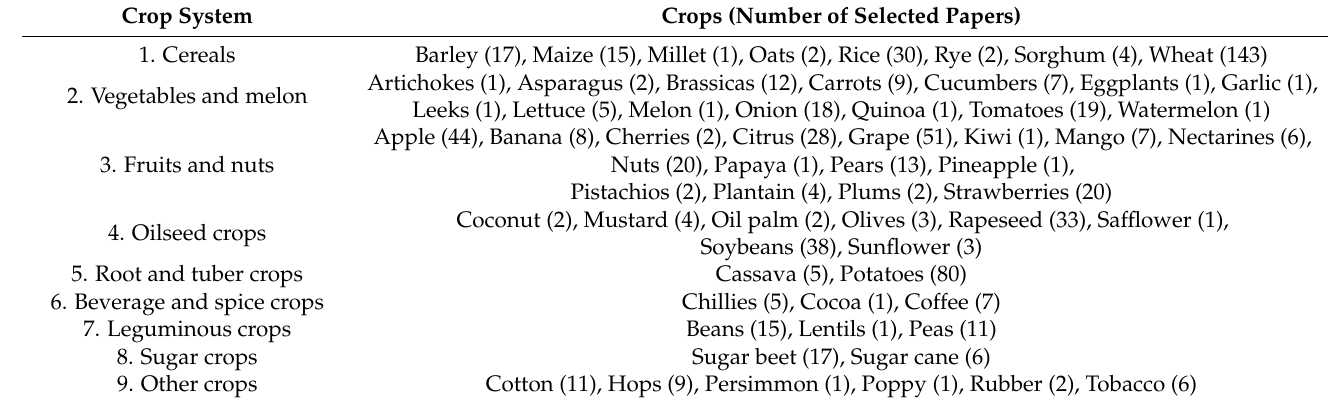
Table 2. Crops belonging to crop systems according to the Indicative Crop Classification (ICC) codes [25], and the number of selected papers for each crop (in brackets).